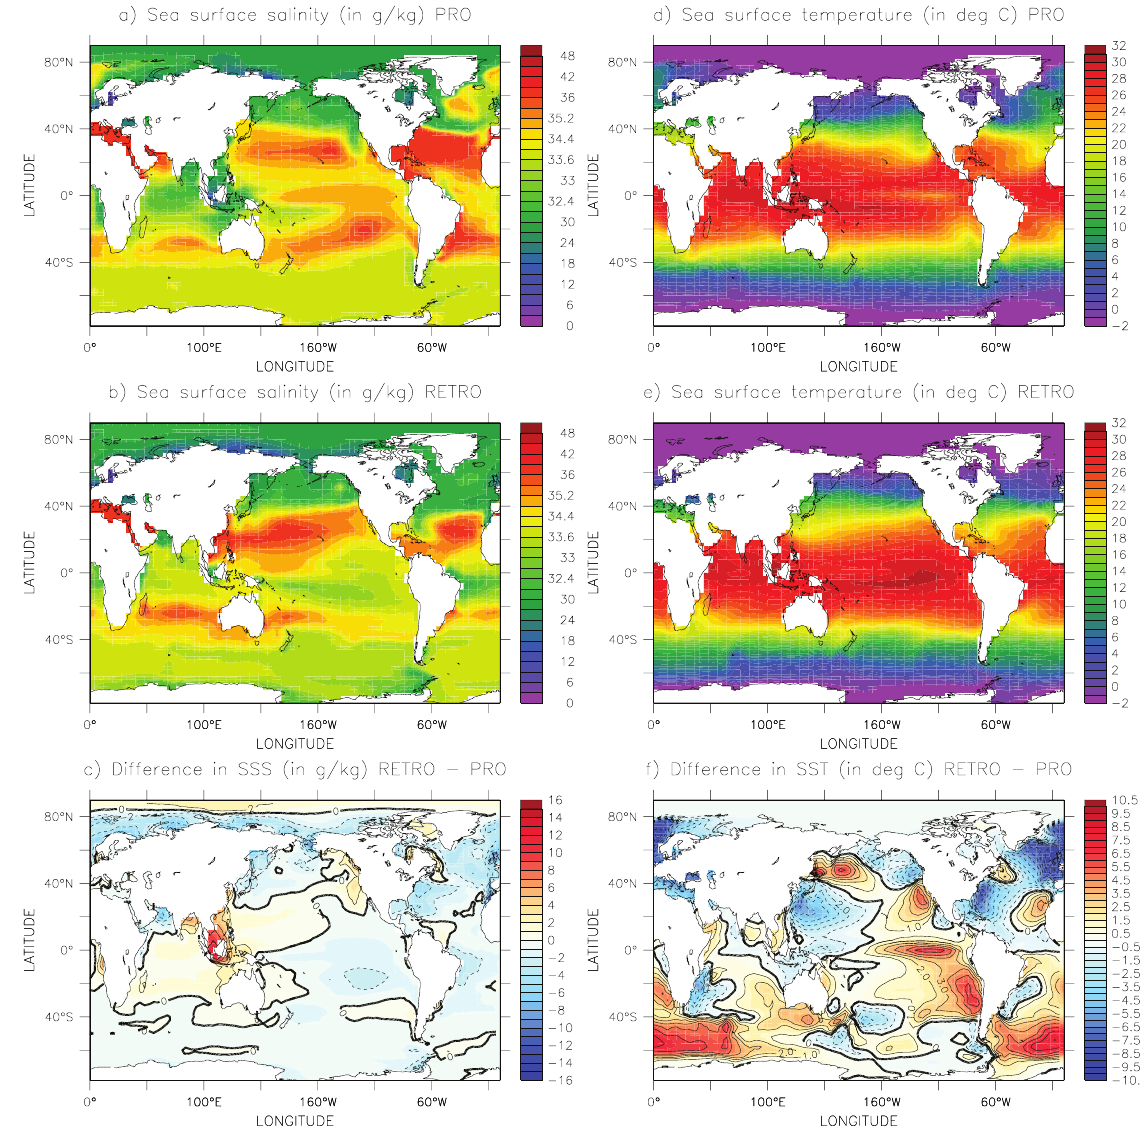
Fig. 3. Sea surface salinity (SSS, g/kg) and sea surface temperature (SST, ◦ C). SSS of (a) PRO; (b) RETRO and (c) their difference field; SST of (d) PRO; (e) RETRO and (f) their difference. In the difference field of SSS it is clear that the Atlantic is much fresher in RETRO than in PRO. The SST difference field shows a dipole structure that arises from the reversal of the wind driven gyres. Shown are the means of the years 400–500 of the CCSM3